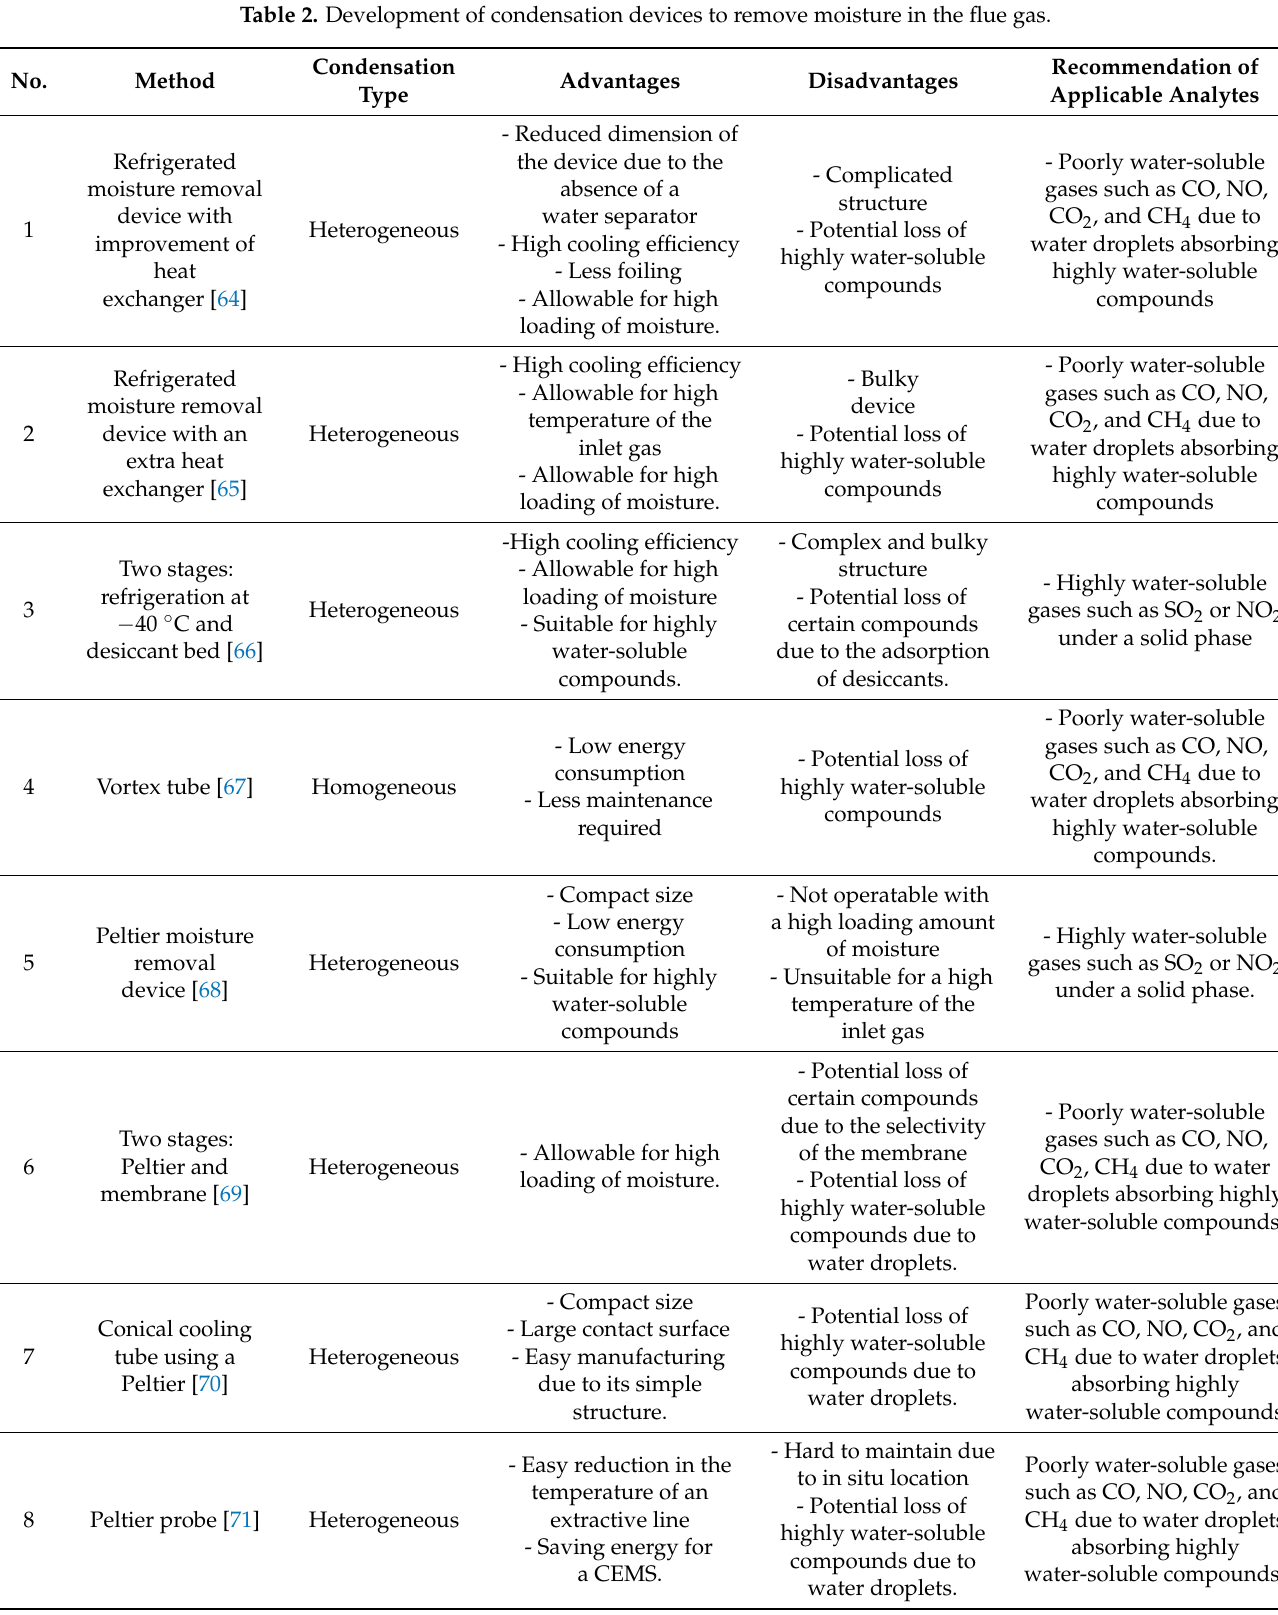
Table 2. Development of condensation devices to remove moisture in the flue